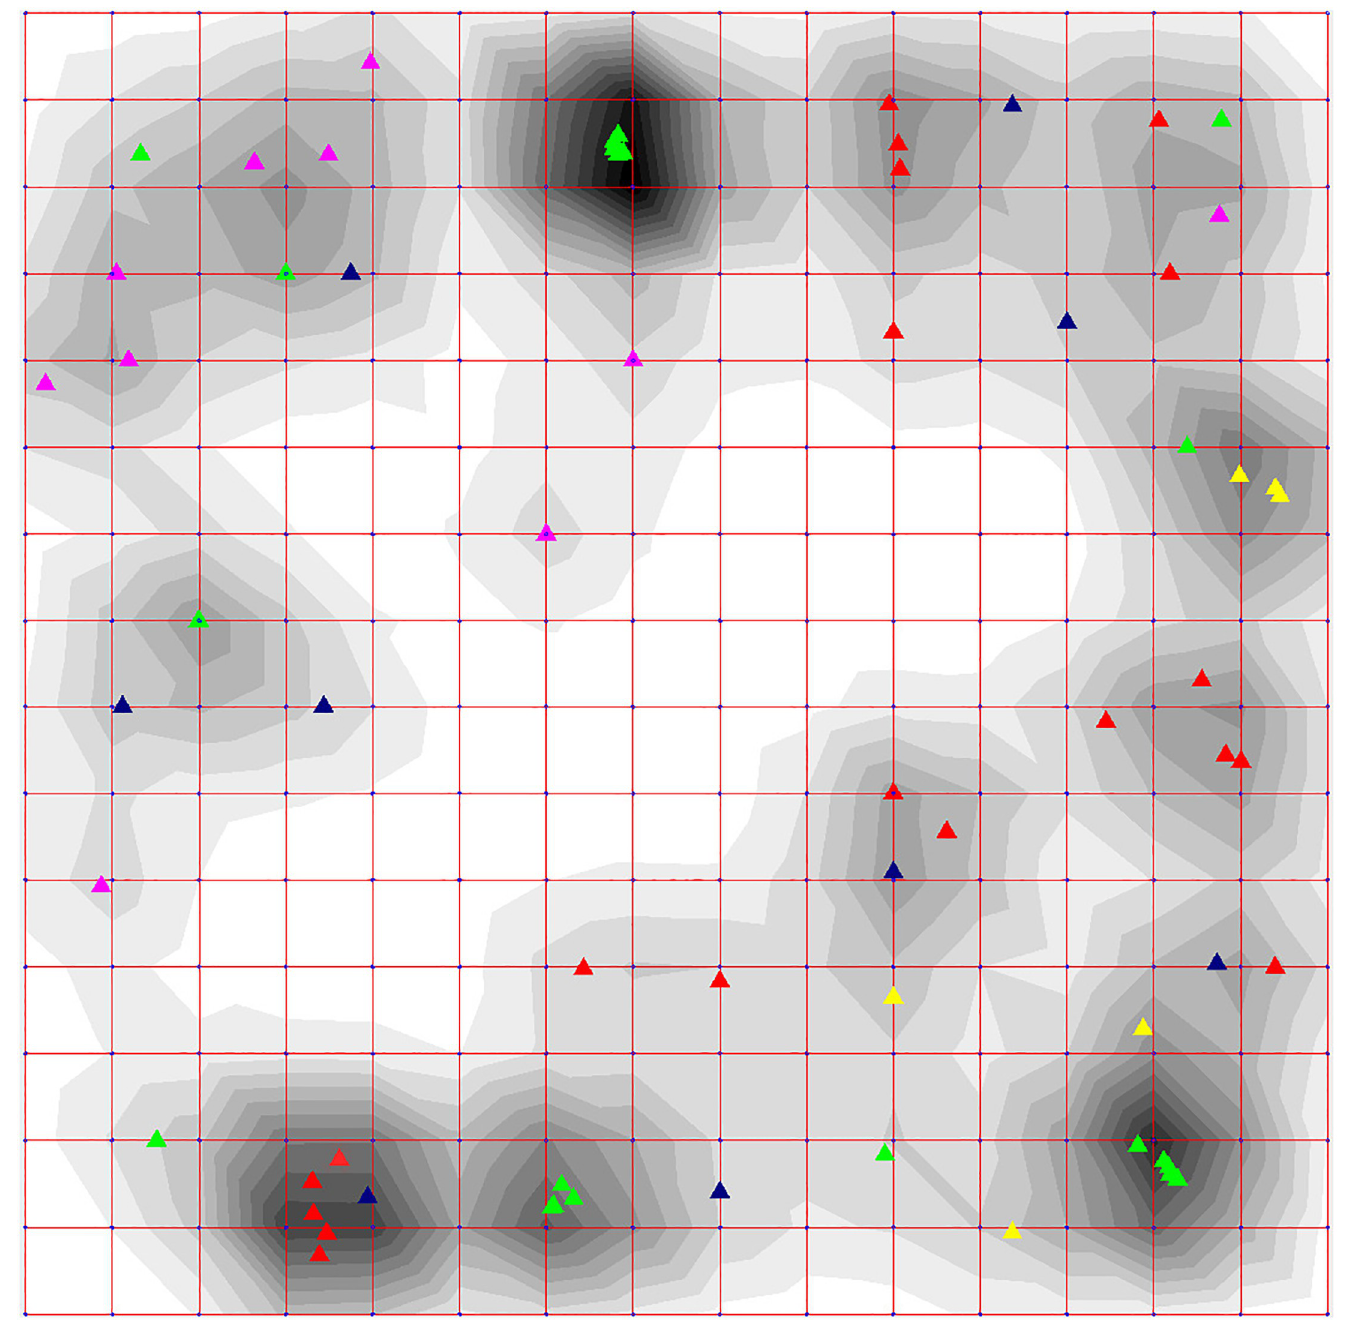
Fig 6. Elastic map of the 16 × 16 type in internal coordinates reflecting local density by shades of grey contours and demonstrating 69 coronavirus genomes depicted by differently colored triangle dots. Red triangle dots depict alphacoronaviruses, green—betacoronaviruses, yellow—gammacoronaviruses, pink— deltacoronaviruses, and dark